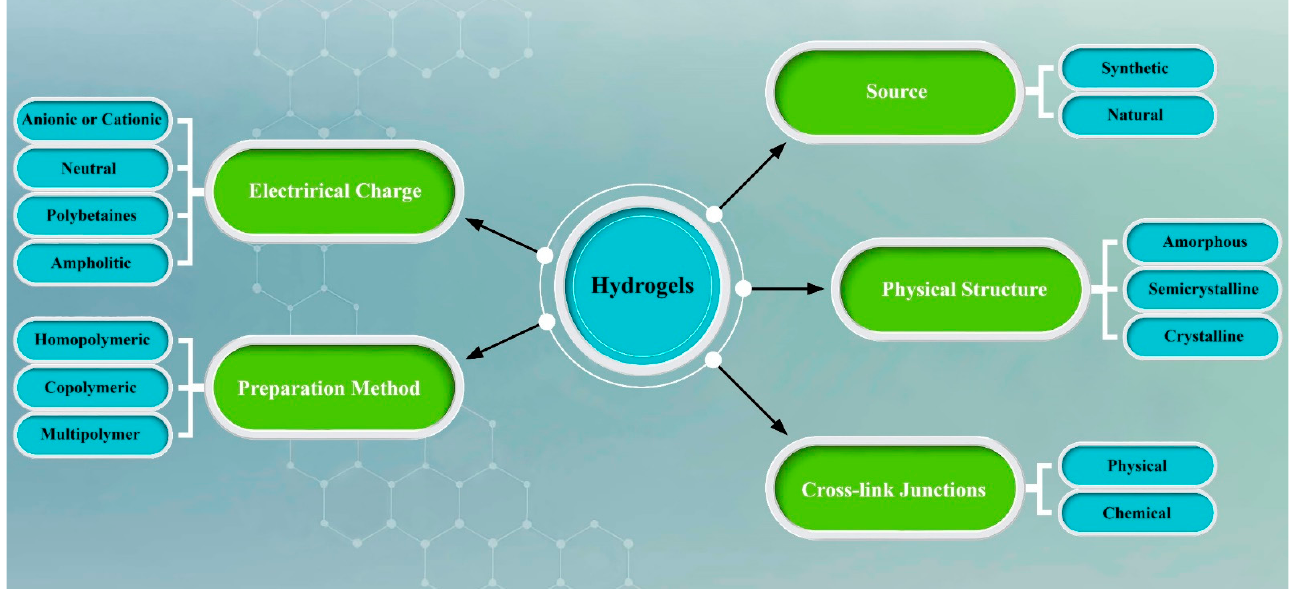
Figure 3. Schematic of hydrogels based on electrical charge, preparation method, source, physical structure, and cross-link junction. Photoshop 2020 was used to create this figure.